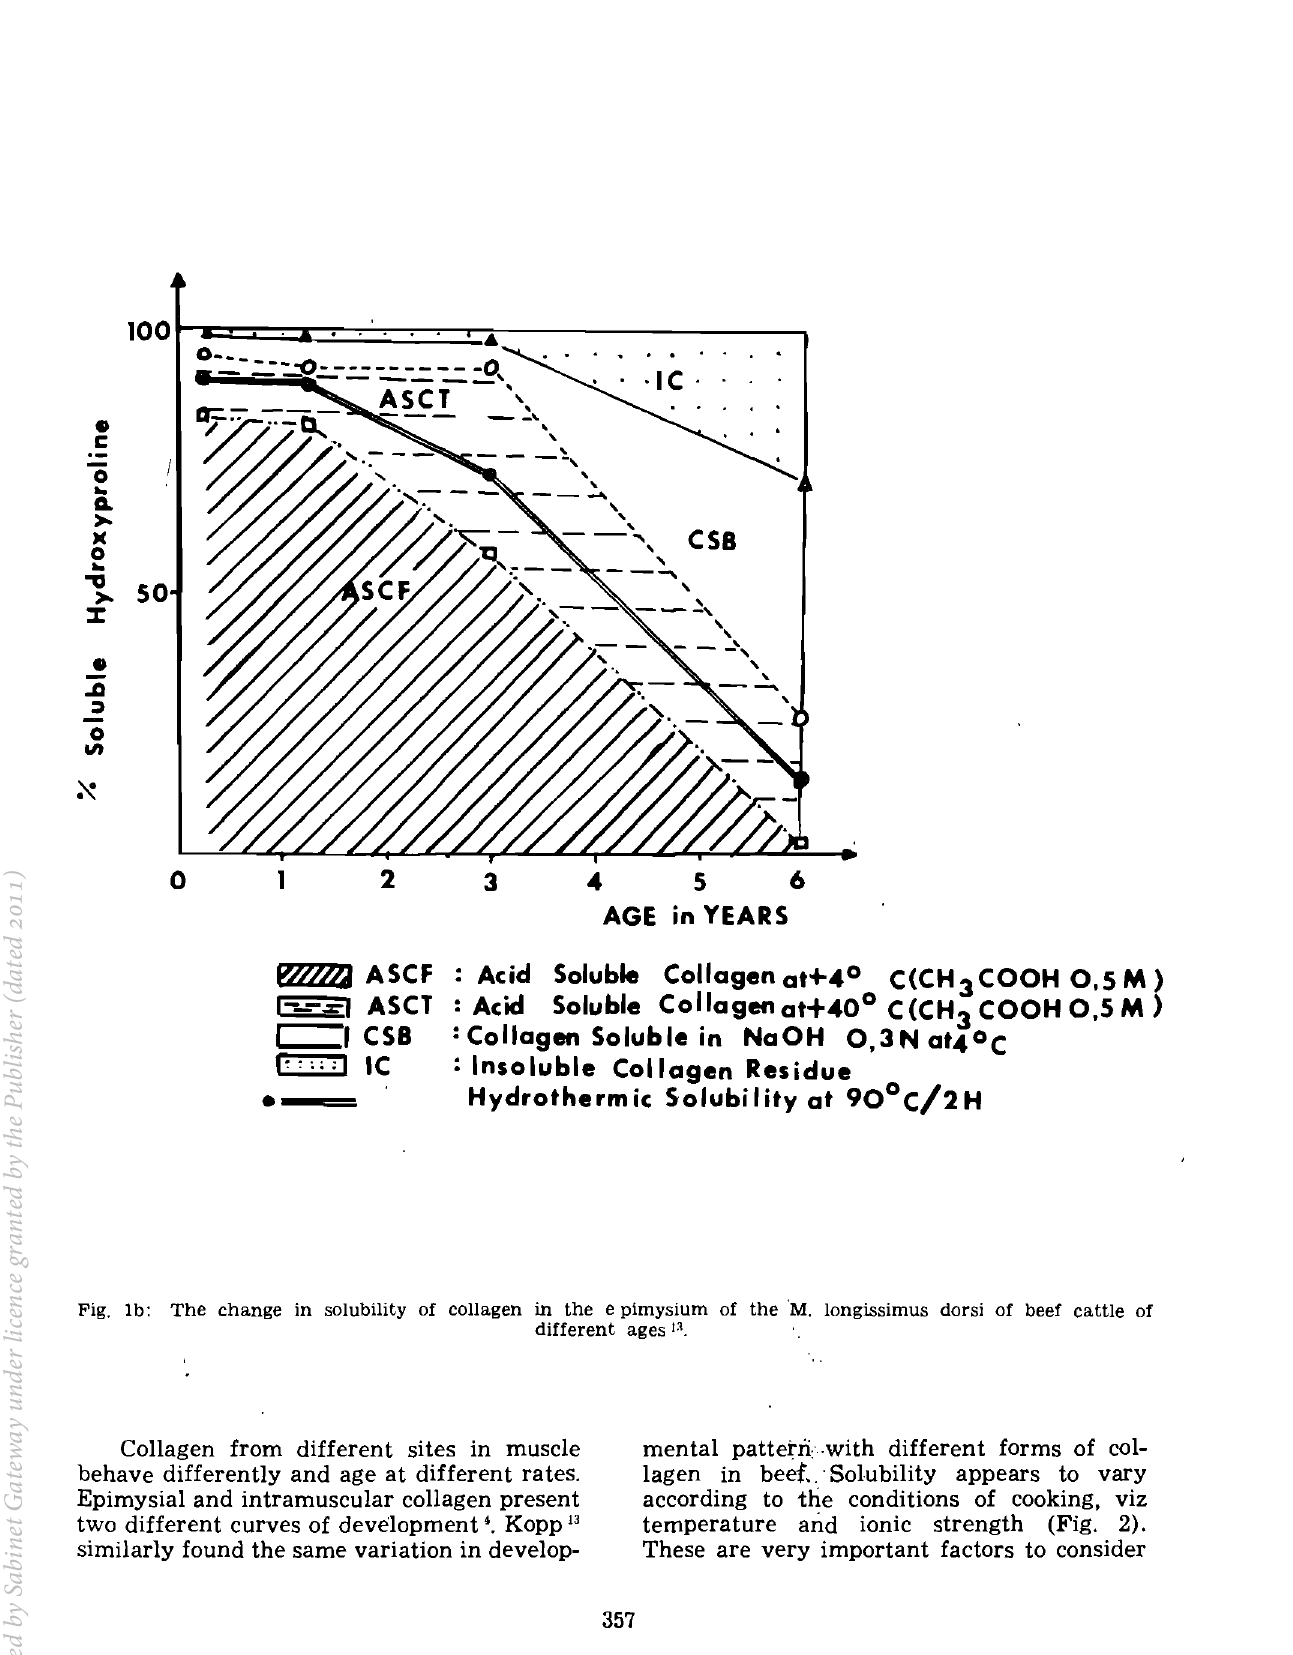
Collagen from different sites in muscle behave differently and age at different rates. Epimysial and intramuscular collagen